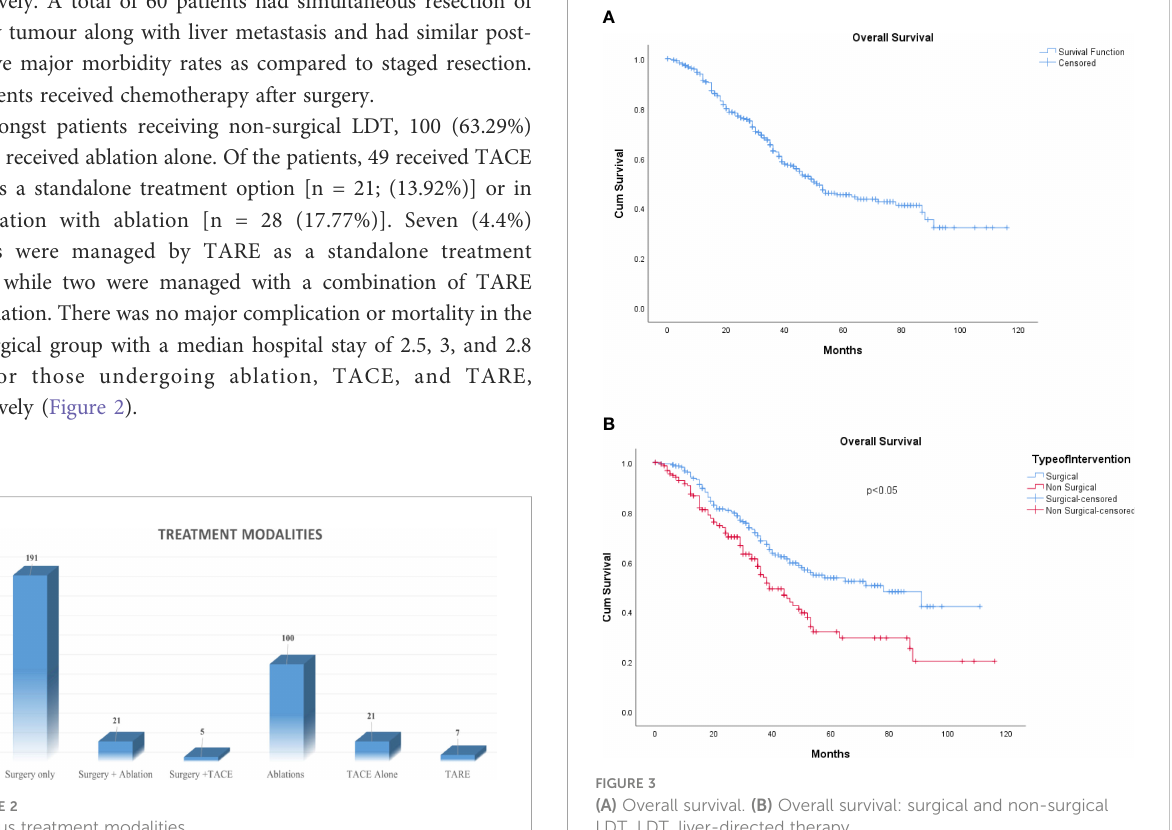
FIGURE 2 Various treatment modalities.